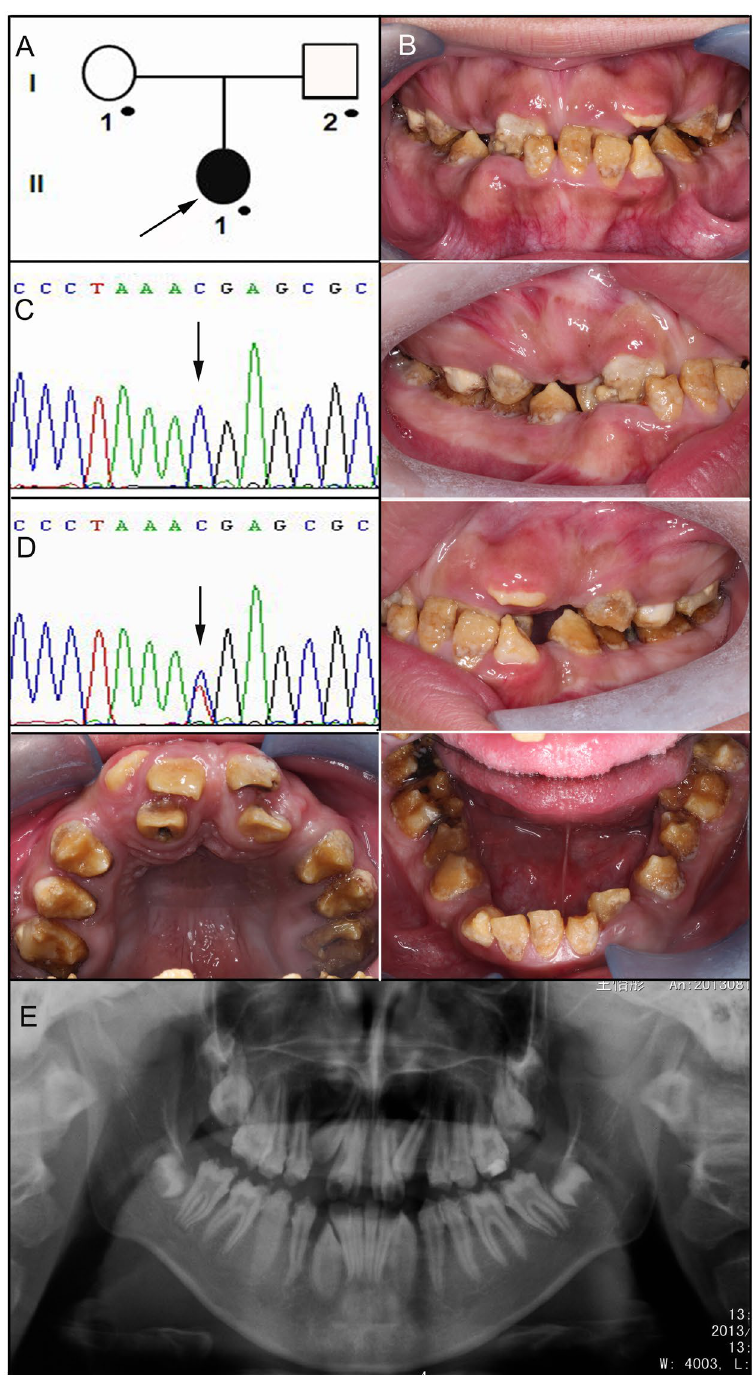
Figure 4. Clinical and mutational analysis of Family 4. ( A ) Pedigree of Family 4, Proband (II:1). Black dots indicate members recruited for this study. ( B ) Oral photographs showing enamel malformations categorized as hypocalcified AI. ( C , D ) FAM83H exon 5 sequencing chromatogram of an unaffected family member (I:1) ( C ), and the proband (II:1) ( D ), revealing a previously reported nonsense mutation: c.973 C > T, p.R325X. ( E ) Panoramic radiograph of the proband taken at the age of